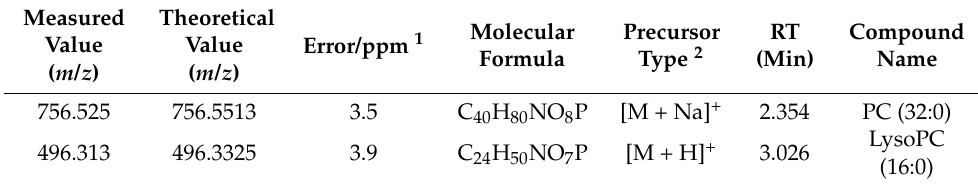
Table 4. Identification of different lipids detected in the scent glands during the breeding and non-breeding seasons by MALDI-MS/MS and LC-MS/MS in the positive ion